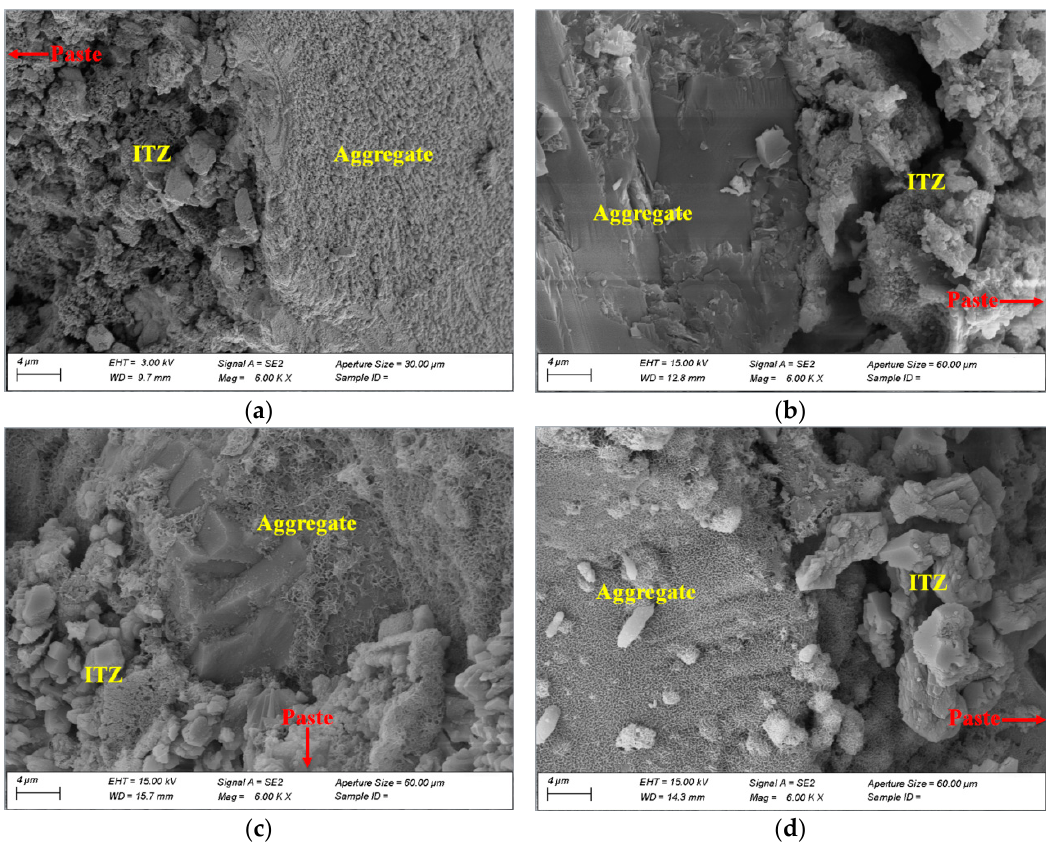
Figure 8. SEM test results for ITZ in concrete prepared with pure cement and RM–YPS–cement with dolomite and basalt aggregates, respectively (( a ): RM–YPS–cement–basalt aggregate; ( b ): pure cement-basalt aggregate; ( c ): RM–YPS–cement– dolomite aggregate; ( d ): pure cement–dolomite aggregate).